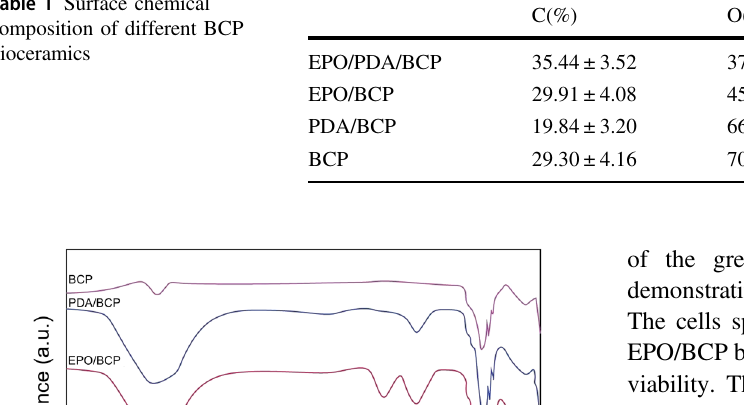
Table 1 Surface chemical composition of different BCP bioceramics